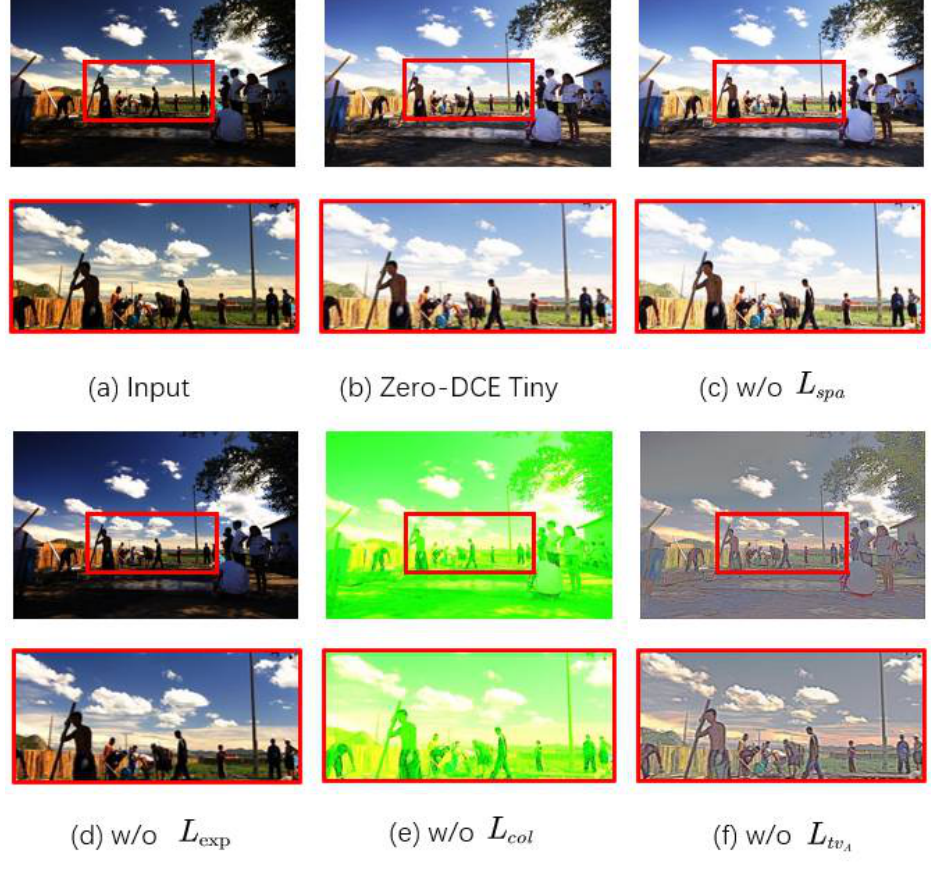
Figure 5. Ablation study of each loss. Subfigure ( a ) shows the original input, subfigure ( b ) shows the enhanced image result through Zero-DCE Tiny method, subfigure ( c – f ) respectively show the image enhancement results after removing spatial consistency loss, exposure control loss, color consistency loss and illumination smoothness